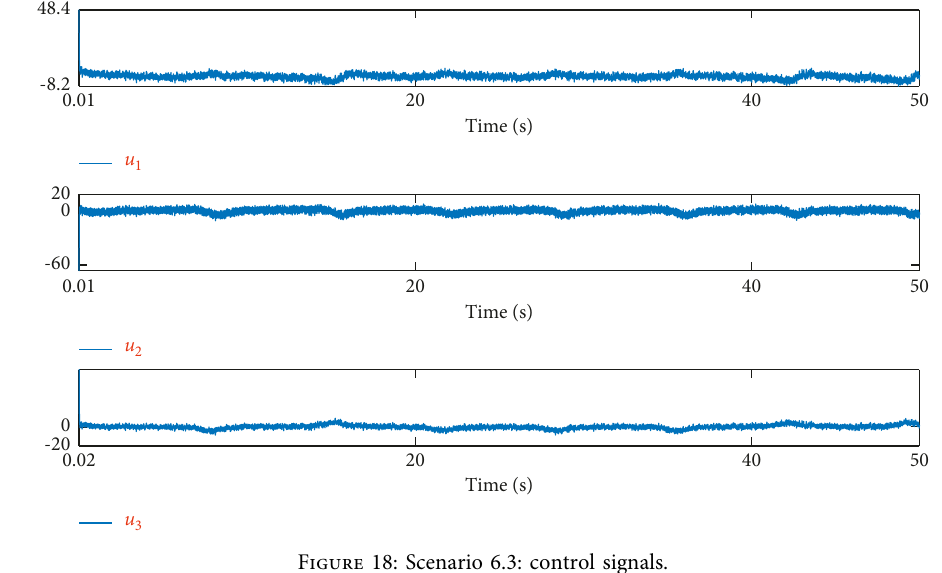
Figure 18: Scenario 6.3: control signals.